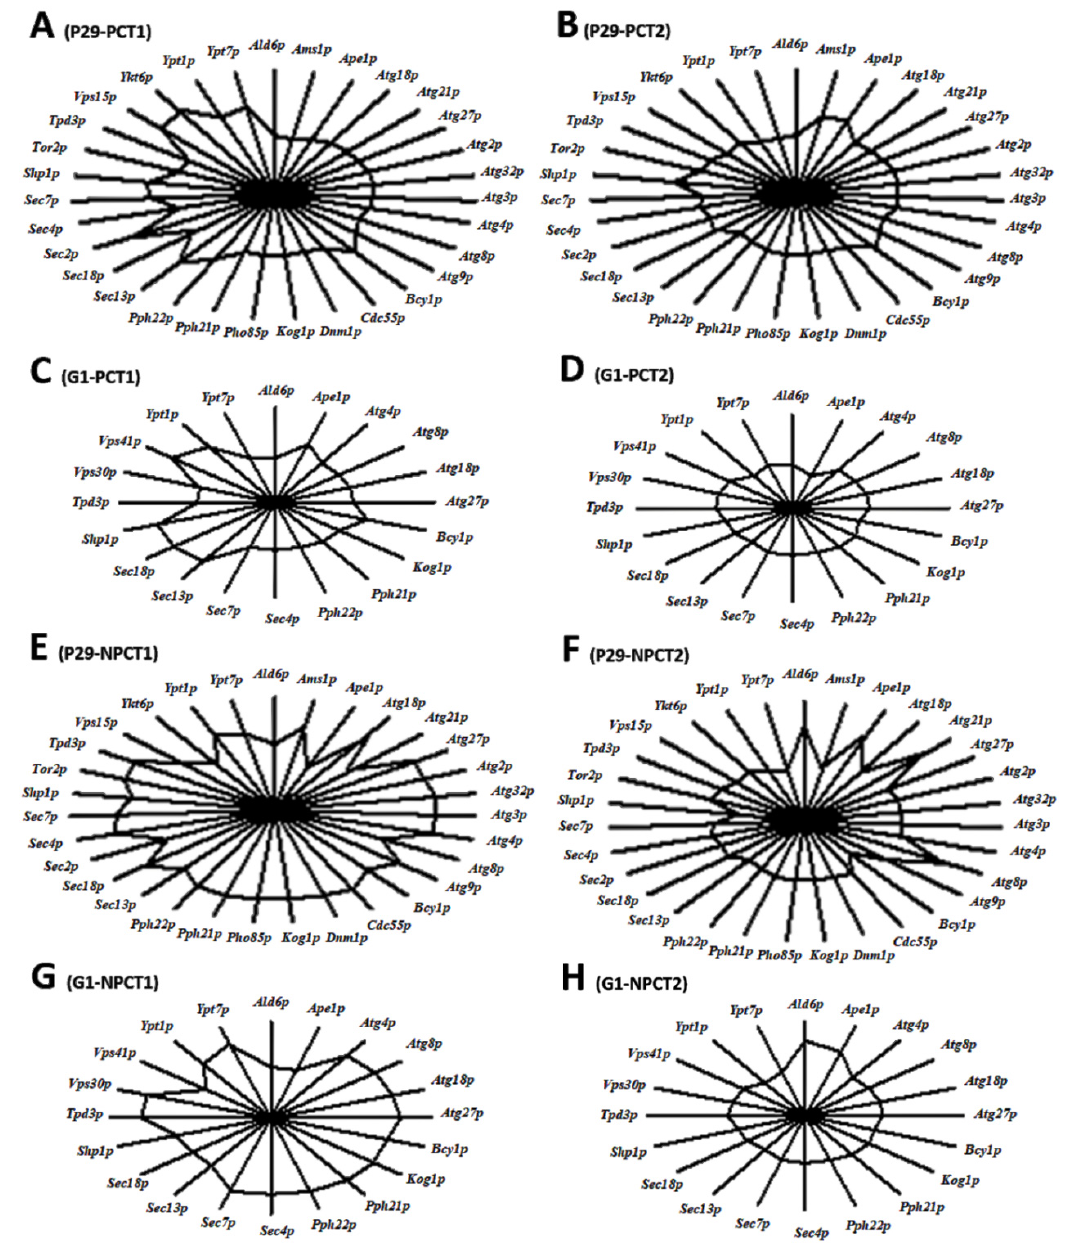
Figure 2. Sunray plots obtained by multivariate data analysis of autophagy proteins detected in S. cerevisiae P29 and G1. Each ray represents a protein and the distance from the center to each vertex indicates the value of each protein. The end of the ray corresponds to the mean value plus three standard deviations and the center the mean minus three standard deviations. ( A ) P29-PCT1; ( B ) P29-PCT1; ( C ) G1-PCT1; ( D ) G1-PCT2; ( E ) P29-NPCT1; ( F ) P29-NPCT2; ( G ) G1-NPCT1; ( H ) G1-NPCT1. PC (endogenous CO 2 overpressure condition), NPC (non-pressure condition), T1 (middle of the second fermentation), T2 (one month after the second fermentation).